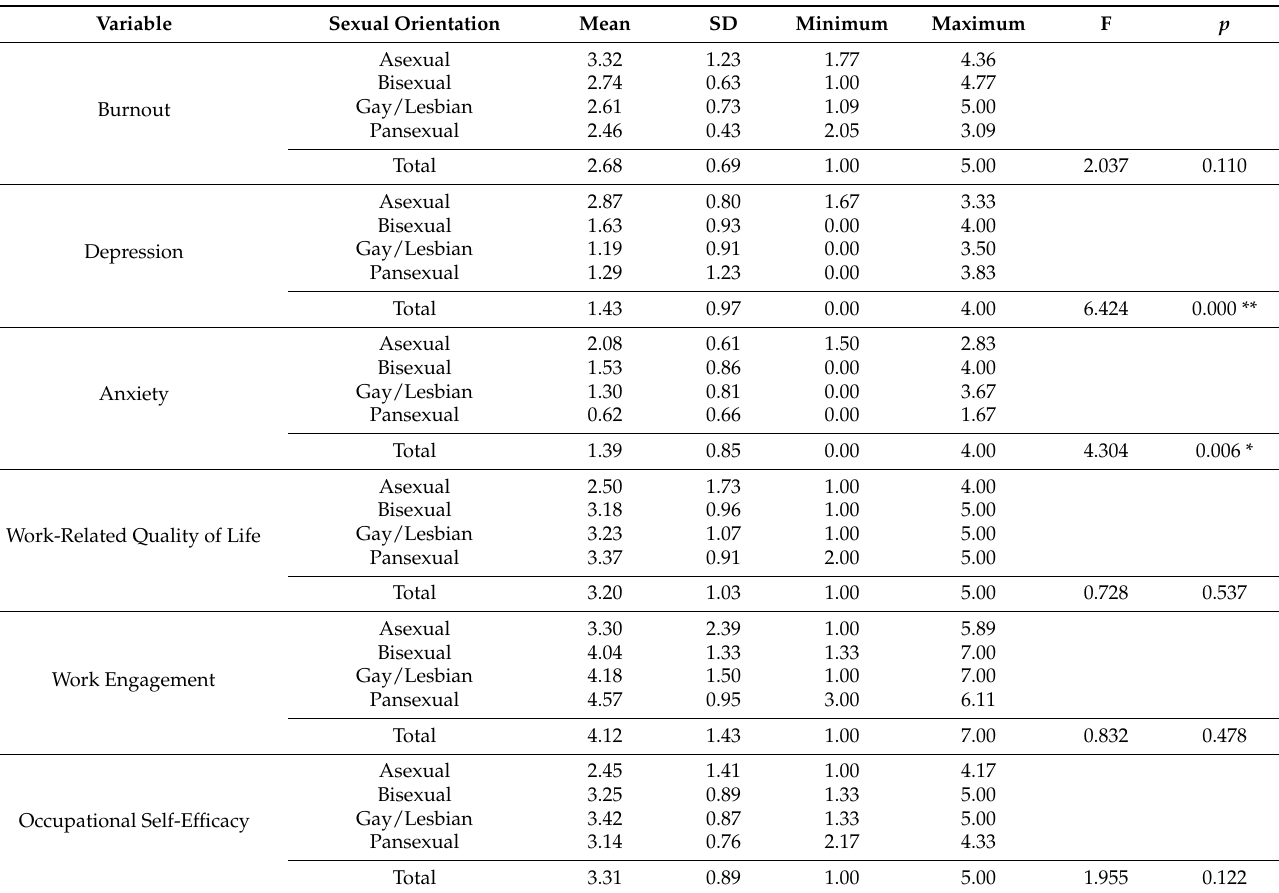
Table 2. Differences in psychological distress variables and occupational well-being indicators by sexual